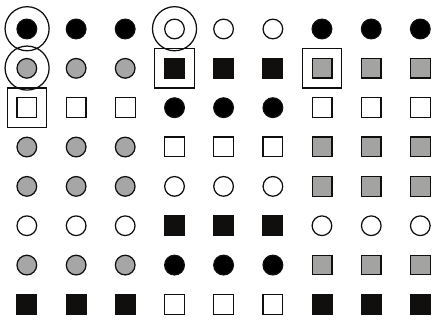
Figure 2.2. The fundamental domain for SL(2, F 3 \ H 9 ) is given by the 6 points which are either circled or